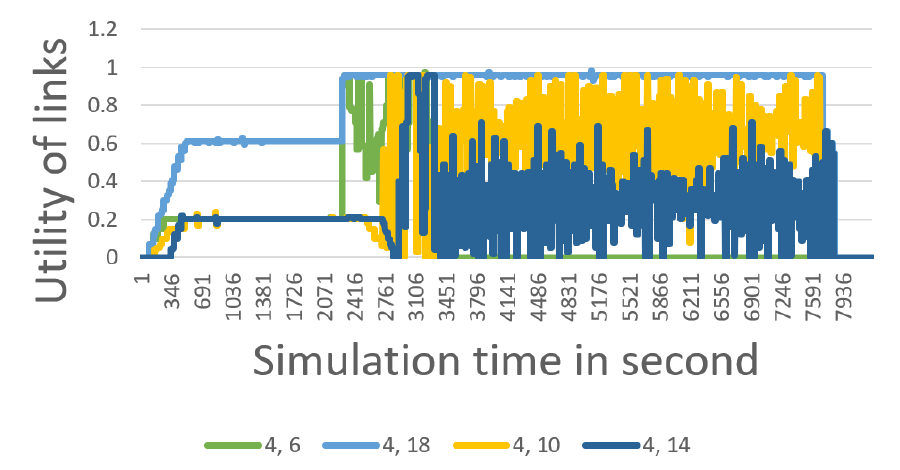
Figure 6. Different fault-tolerance flows sharing one core